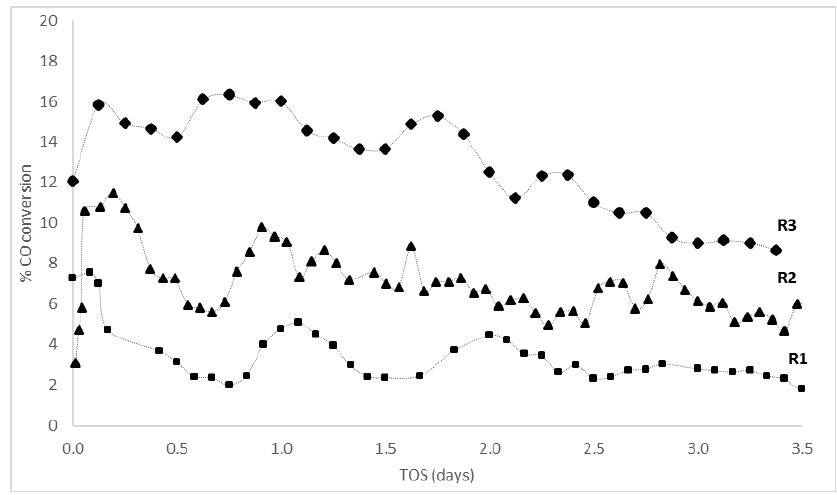
Figure 2. CO conversion for R1, R2, and R3 (refer to Tables 1 and 2 for reaction details).